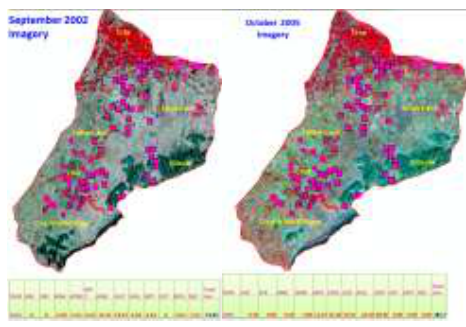
Figure-2- Change Detection between 2002 to 2005